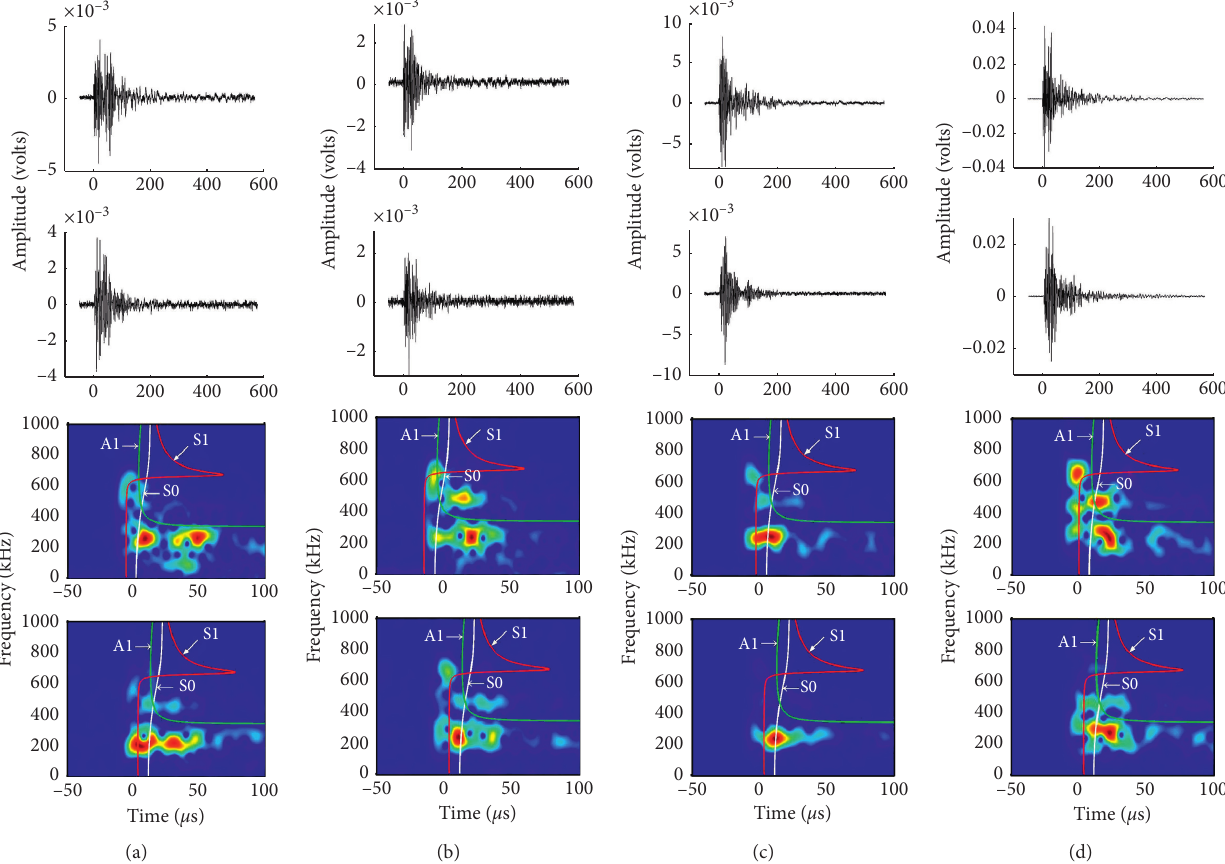
Figure 11: The AE waveform signal and spectrogram in a [0/45/0/-45/0